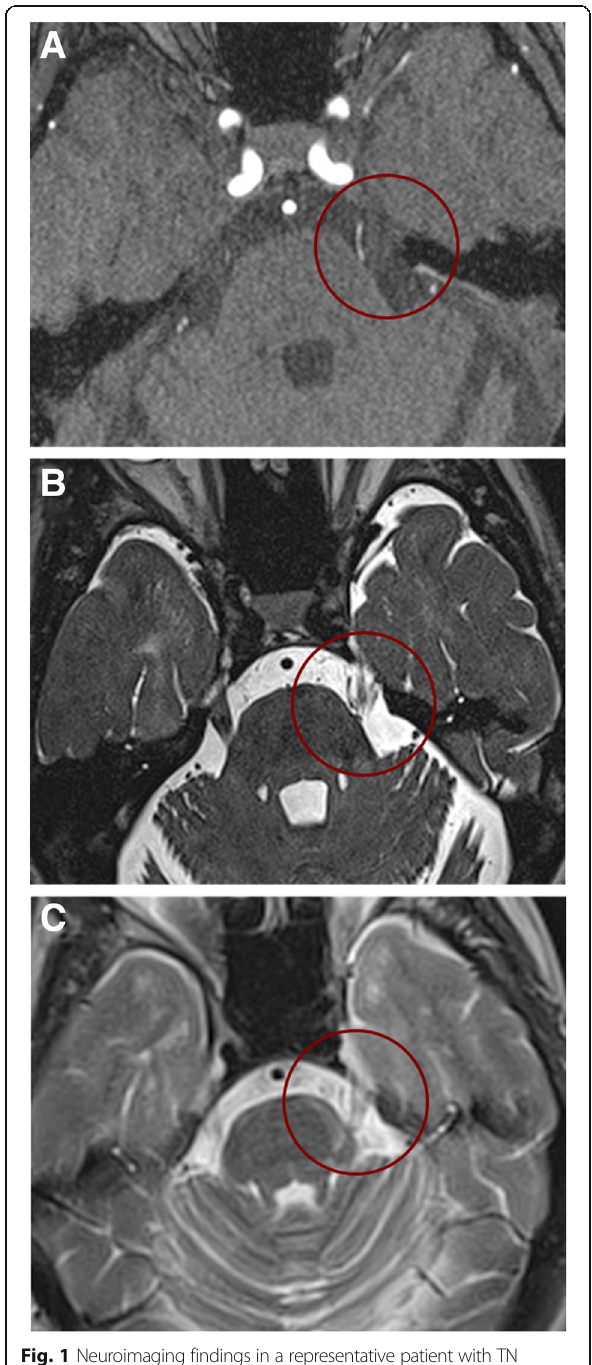
Fig. 1 Neuroimaging findings in a representative patient with TN secondary to MS possibly due to a double crush mechanism. 3D time- of-flight (TOF) magnetic resonance angiography scans ( a ) and 3D constructive interference in the steady state (CISS) T2-weighted ( b ) on the axial plane demonstrate left neurovascular compression (NVC) with associated trigeminal nerve atrophy. T2-weighted image on the axial plane shows a hyperintense pontine lesion at the left trigeminal nerve root entry zone (REZ) ( c ). The arrow indicates the trigeminal nerve ( b ) and the arrowhead the demyelinating plaque ( c ). Reproduced from